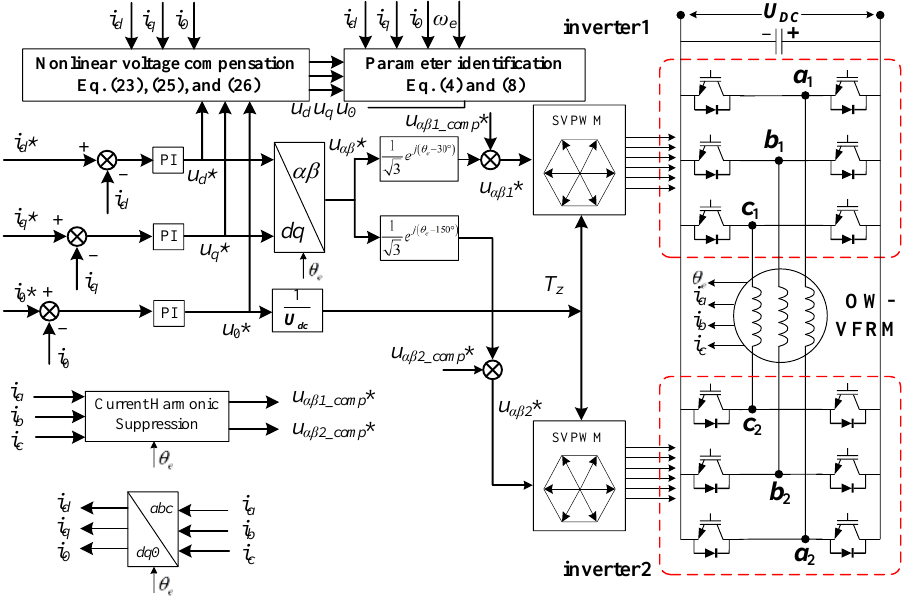
Figure 7. Diagram of the control system.